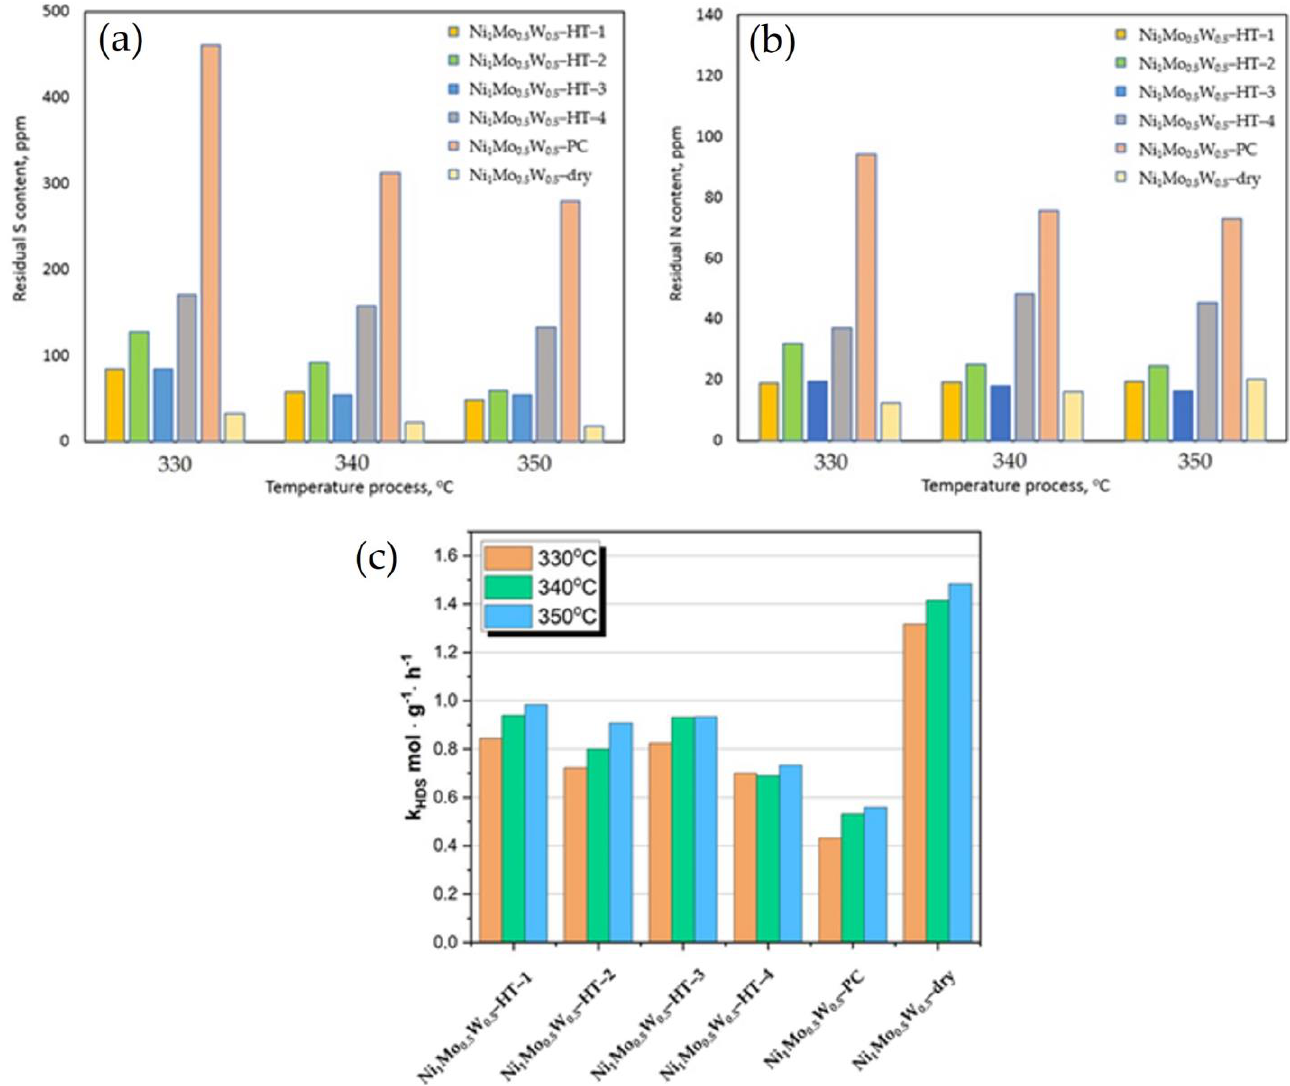
Figure 9. Residual sulfur ( A ) and nitrogen ( B ) content in the liquid product after the hydrotreatment and HDS rate constants for sulfide catalysts ( C ).